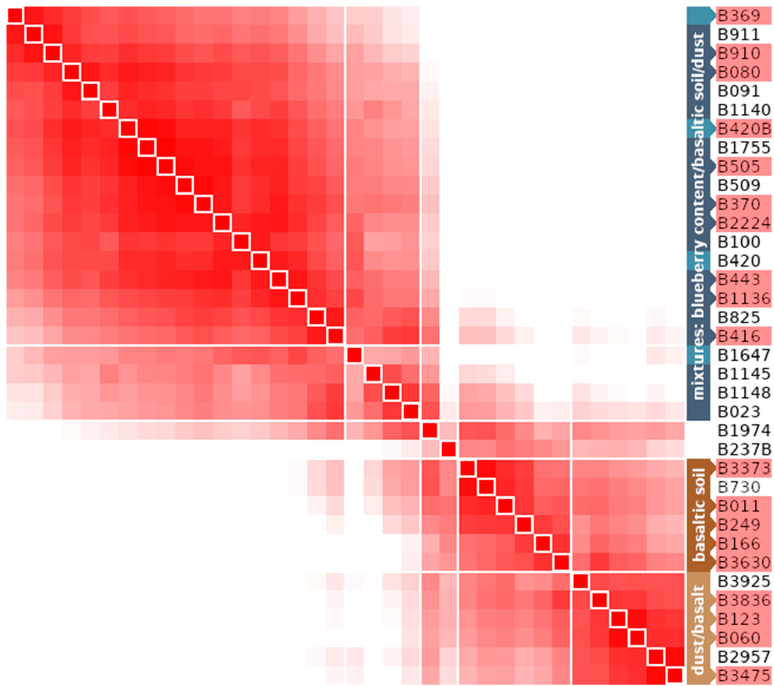
Figure 1. Blocked matrix of similarity distances between pairs of distributions. Table 2. Weight percentages of 10 distributions measured from mixed-material sample targets.